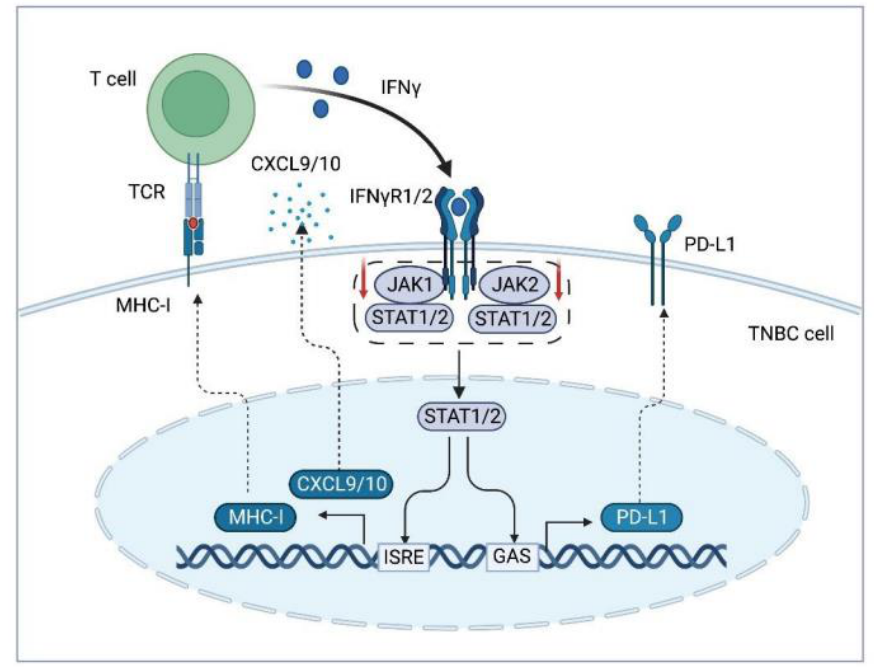
Figure 3. Disturbed IFN- γ signaling pathway results in resistance to anti-PD-1/PD-L1 therapy. IFN- γ secreted by T cells binds to IFN γ R1/2 on the surface of TNBC cells, activating the JAK1/1-STAT1/2 pathway. The phosphorylated STAT1/2 translocates to the nucleus where it binds to GAS and ISRE, promoting the expression of MHC-II, PD-L1 and CXCL9/10. After receiving immunotherapy, tumor cells may downregulate or alter the IFN- γ signaling pathway, such as by reducing JAK1/2 activity to escape the anti-tumor effects of T cell-derived IFN- γ . Abbreviations: PD-L1, programmed cell death 1 ligand 1; TCR, T cell receptor; MHC-I, major histocompatibility complex class I; IFN- γ , interferon- γ ; IFN γ R 1/2, interferon- γ receptor 1/2; JAK 1/2, Janus kinase 1/2; STAT 1/2, signal transducer and activator of transcription 1/2; GAS, growth arrest-specific protein; ISRE, interferon-sensitive response element; CXCL9/10, C-X-C motif chemokine 9/10; TNBC, triple negative breast